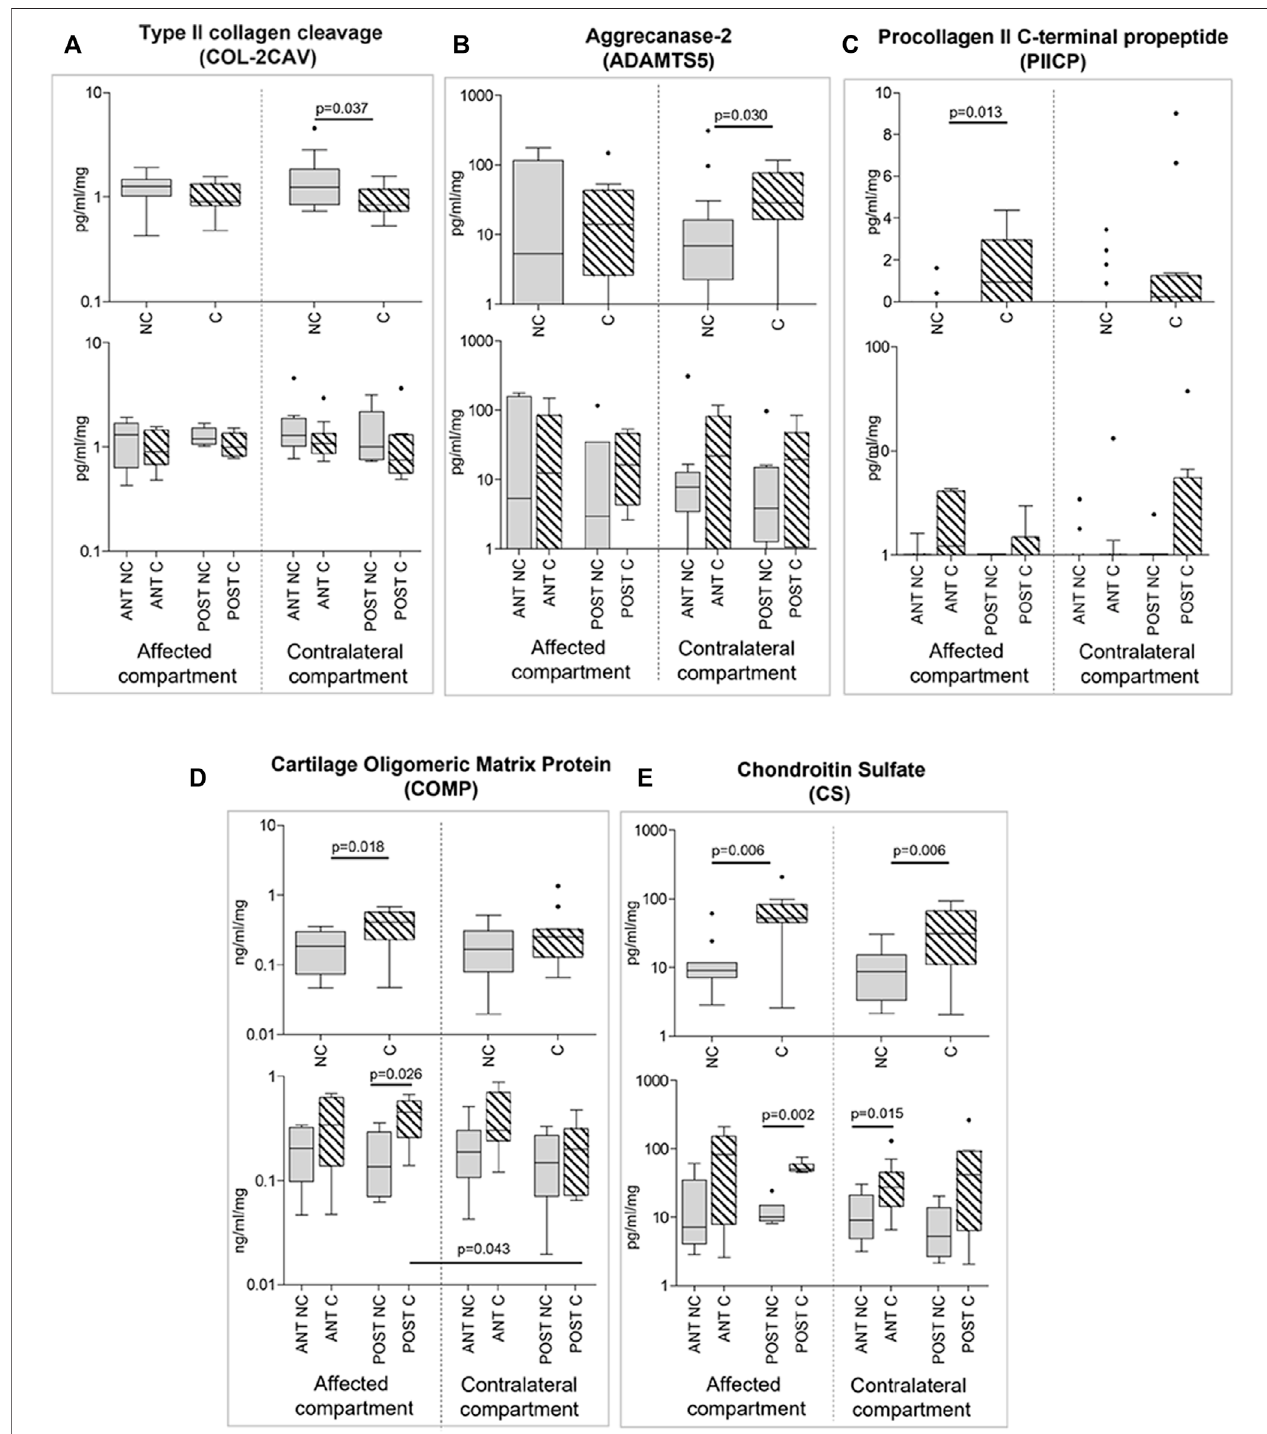
FIGURE7| Effectofcompressiononsolublefactorrelease (A-E) inaffectedandcontralateralcompartments(upperpanelsofeachsection).Inlowerpanelsofeach section, samples are divided according to the original position of the cartilage area (anterior/posterior condyle) (Sidak test for multiple comparisons). Data are presented asmedians(numberofmRNAmoleculesofthegeneofinterest/10 5 GAPDHcopies).Boxesrepresent25 th – 75 th percentiles;whiskersrepresentminimumandmaximum values; dots represent outliers. NC, uncompressed; C, compressed; IL-1 β , stimulated with 2 mg/ml IL-1 β .